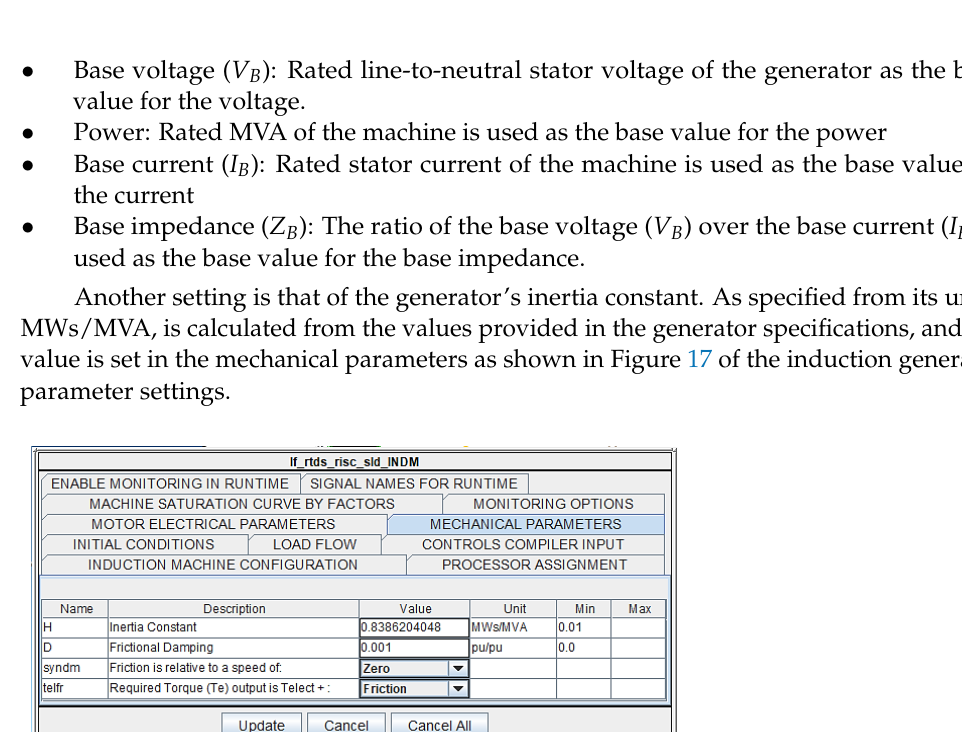
Figure 16. Squirrel - cage induction generator model electrical parameter settings.